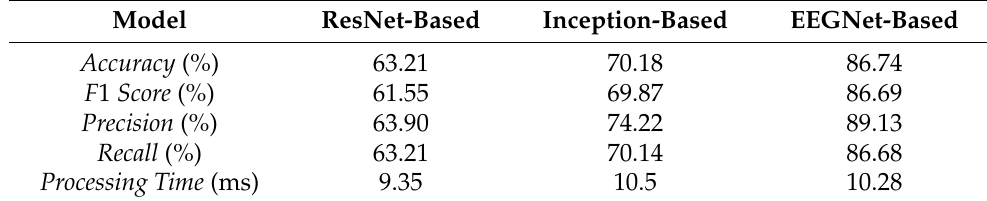
Table 1. Comparison of performance between Deep Learning Models.